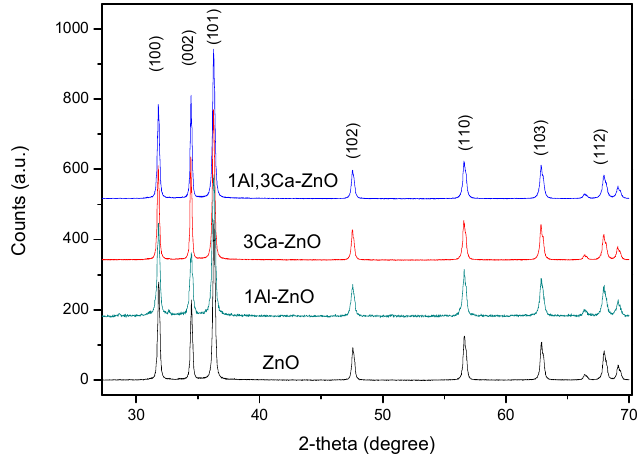
Figure 2. XRD of some representative samples used in this study.